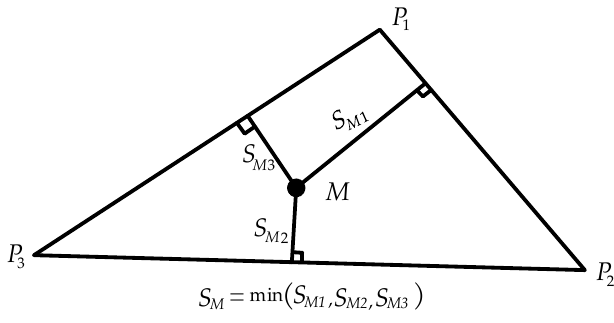
Figure 1. The definition of static stability margin (SSM).